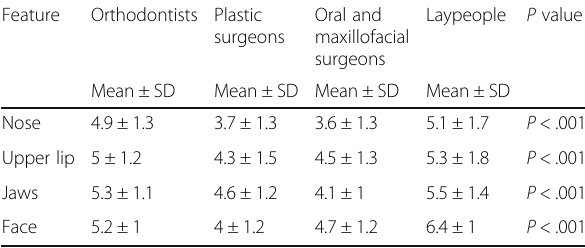
Table 2 Mean assessment scores of the rating panels towards the aesthetics of the nose, upper lip, jaws, and